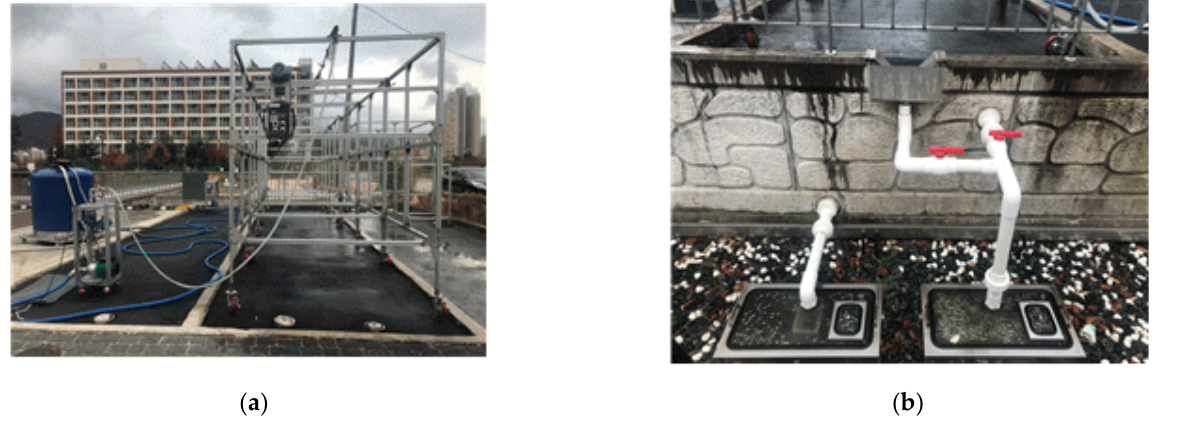
Figure 11. Rainfall simulation test ( a ) test setup; ( b ) outflow gauges for overflowing and draining.